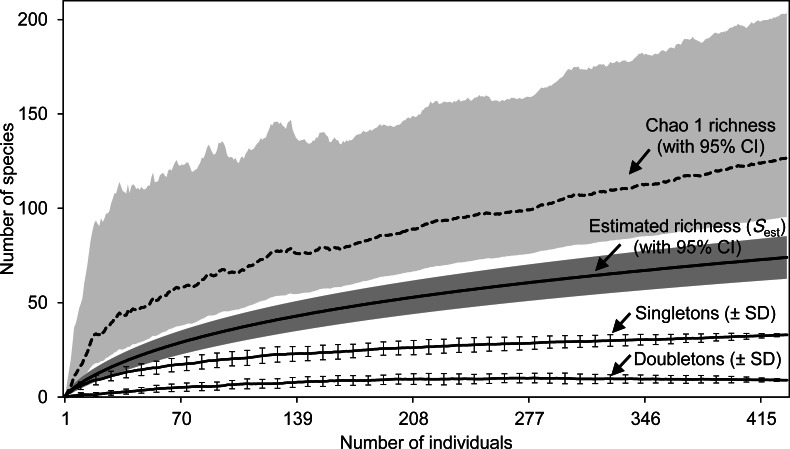
Estimated species richness.Species richness estimates (with 95% confidence intervals) for the estimators Sest (analytical) and Chao 1 Classic (dashed line) based on 100 randomized samples (Colwell, 2013) for the total data of entomofauna sampled in Sabkha Djendli, Northeast Algeria. Rarefaction curves were represented by means of singletons and doubletons (± standard deviations, only every 8th data point is shown).